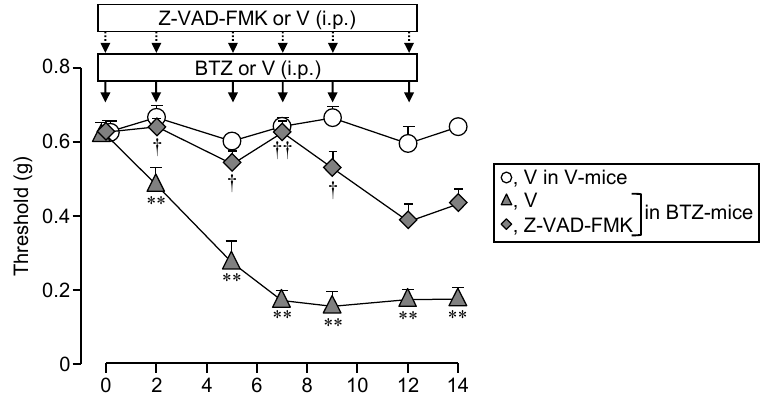
Figure 8. Repeated administration of Z-VAD-FMK, a pan-caspase inhibitor, completely prevents the development of CIPN following bortezomib treatment in mice. Bortezomib at 0.4 mg/kg or vehicle was administered i.p. on days 0, 2, 5, 7, 9, and 12. The mice received repeated i.p. administration of Z-VAD-FMK at 1 mg/kg, 30 min before each dose of BTZ. Data show the mean with S.E.M for 5 mice. V, vehicle; BTZ, bortezomib. ** p < 0.01 vs. V in V-treated mice. † p < 0.05, †† p < 0.01 vs. V in BTZ-treated mice.